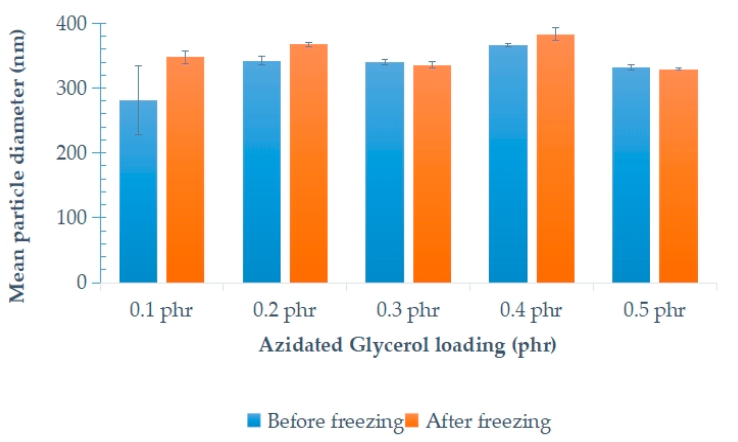
Figure 9. Mean diameter of NRL with variable loadings of AG, before freezing and after the freeze– thaw processes.